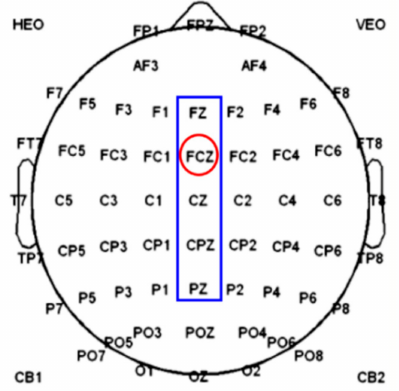
Figure 2. The location of five selected channels. FCz channel (inside the red circle) was used for error-related potentials (ErrPs) waveform analysis, and the five channels (inside the blue box) were used for classification. FCz: Frontal central; HEO: Horizontal electrooculogram; VEO: Vertical